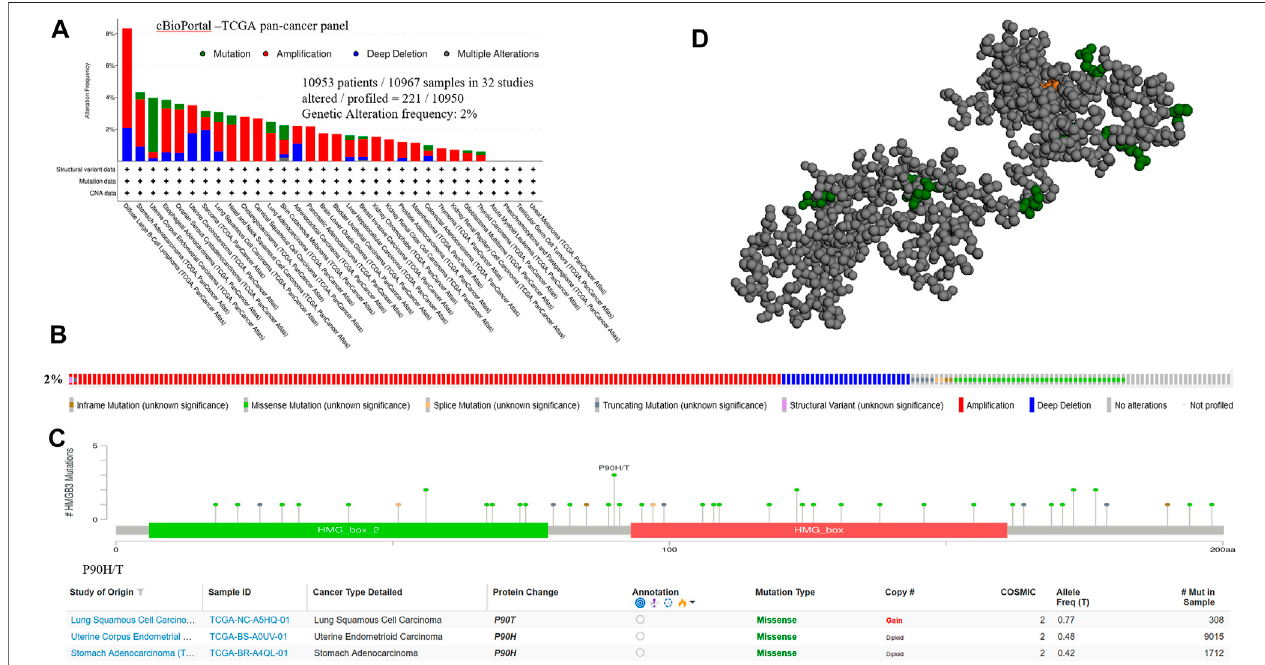
FIGURE3| Geneticalterations ofHMGB3 intumor tissues. (A) MutationsofHMGB3 intumor tissues areshown sequentiallyfrom toptobottom. (B) Frequency of genetic alterations in HMGB3. (C) Details of all mutations in tumor. (D) 3D structure of P90H/T.